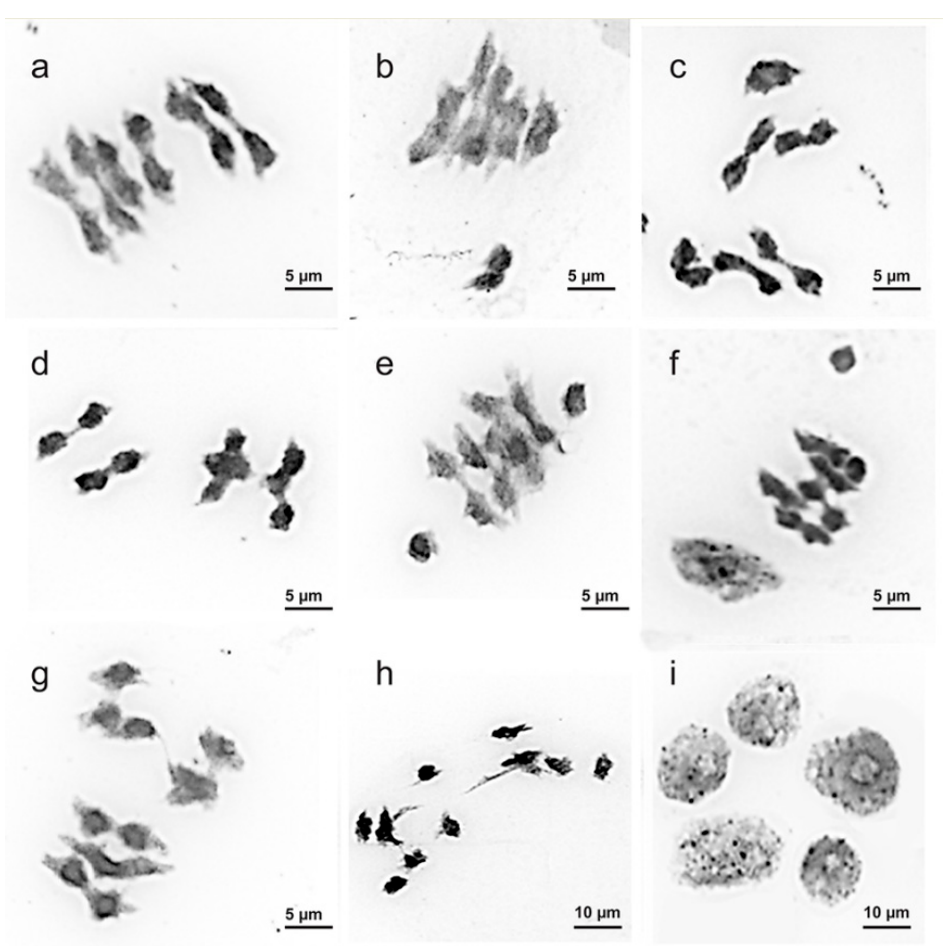
Figure 4. Chromosome behavior during meiosis observed in the studied Chelidonium majus plants: ( a ) M-I, 6 II , ( b ) M-I, several chromosomes are localized outside the metaphase plate, ( c ) M-I, 4 II + 1 IV , ( d ) M-I, 2 II + 2 IV , ( e ) M-I, 5 II + 2 I , ( f ) M-I, 5 II + 1 I , ( g ) A-I, chromosome lagging, ( h ) A-I, chromosome